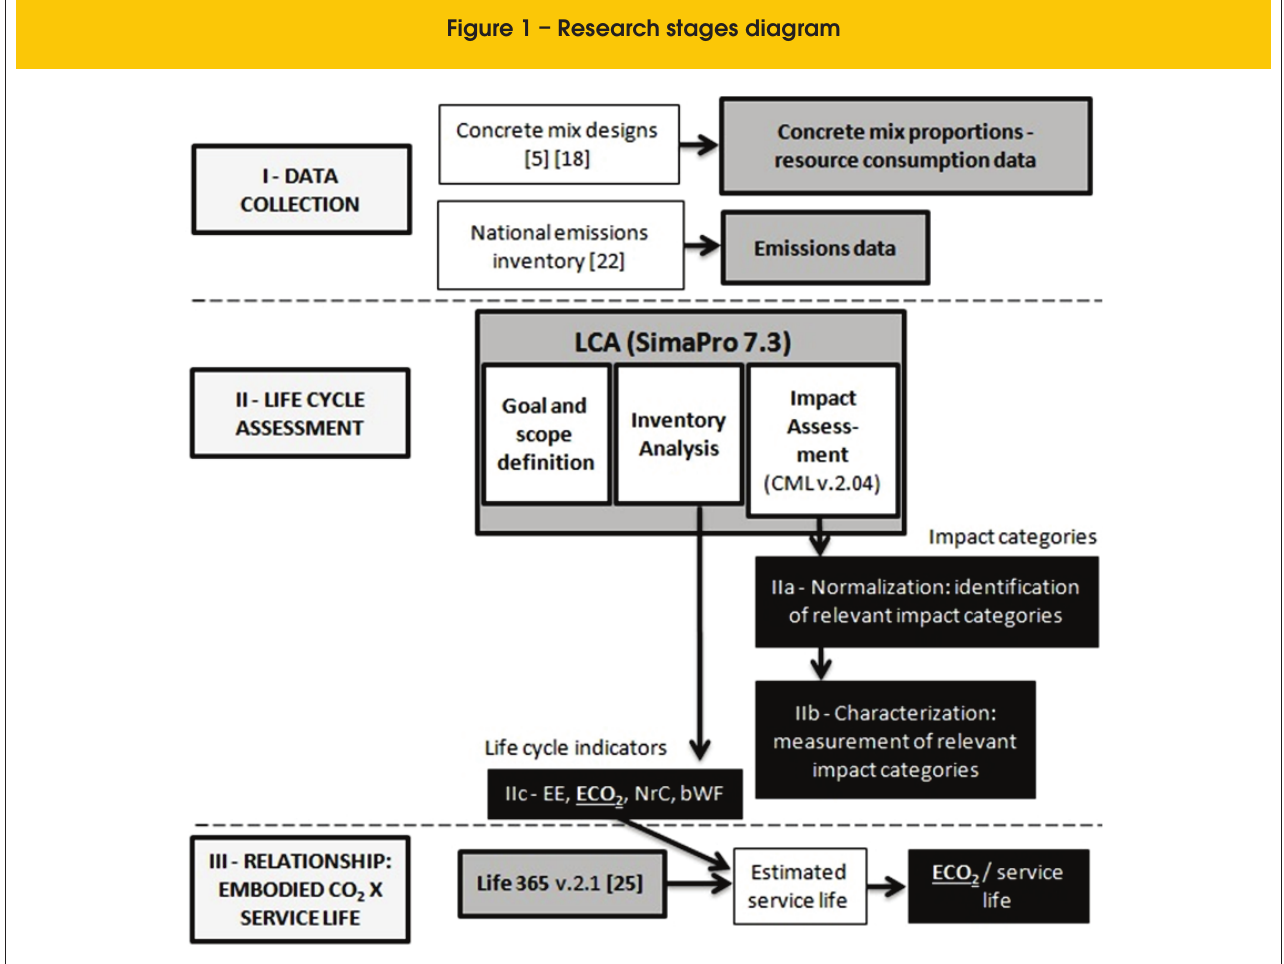
Figure 1 – Research stages